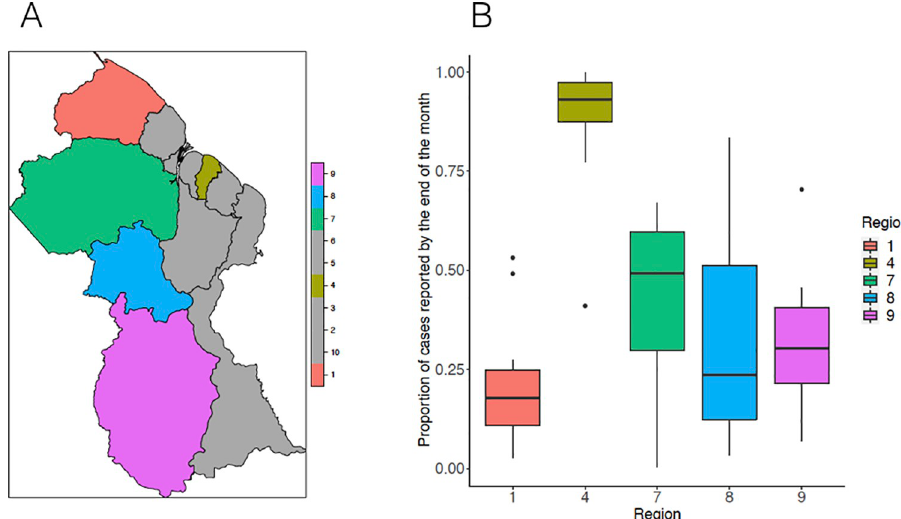
Fig 1. A. Map of malaria endemic regions and region 4; B. Boxplot reporting the proportion of annually aggregated cases from 2006–2019 reported by the end of the month for each region, with colors corresponding to the regions depicted in the map. Map created using the R package ssplot